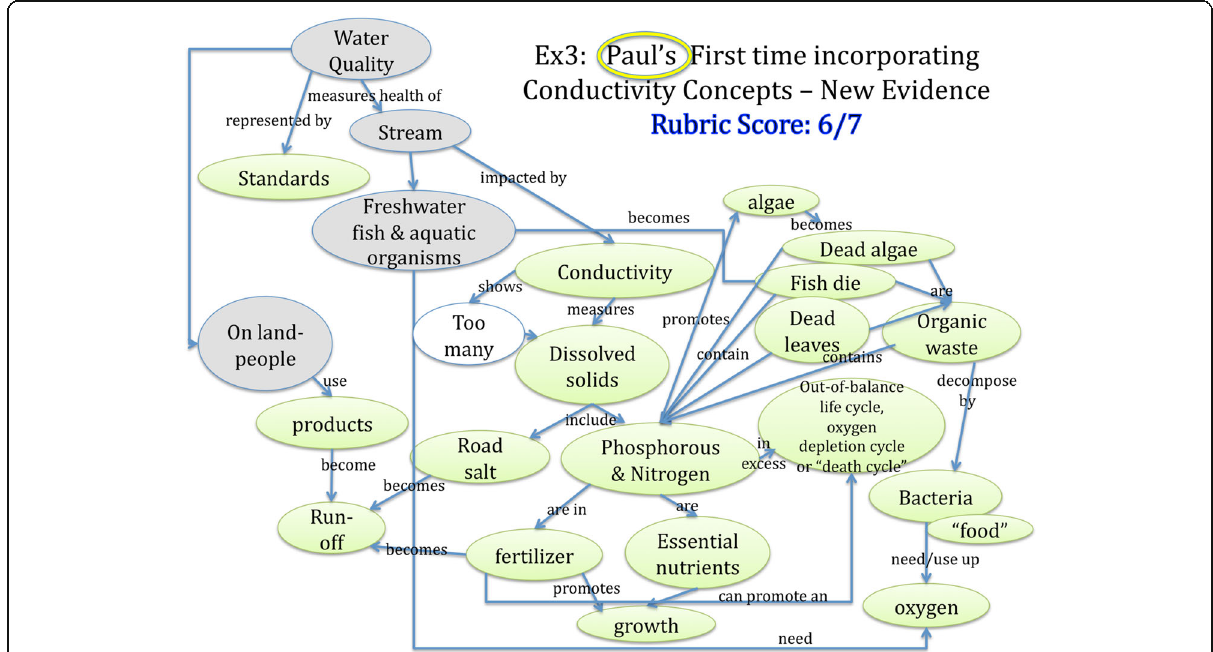
Fig. 9 Paul ’ s Explanation 3 (Ex3): First time Conductivity Concepts. Rubric Score 6/7